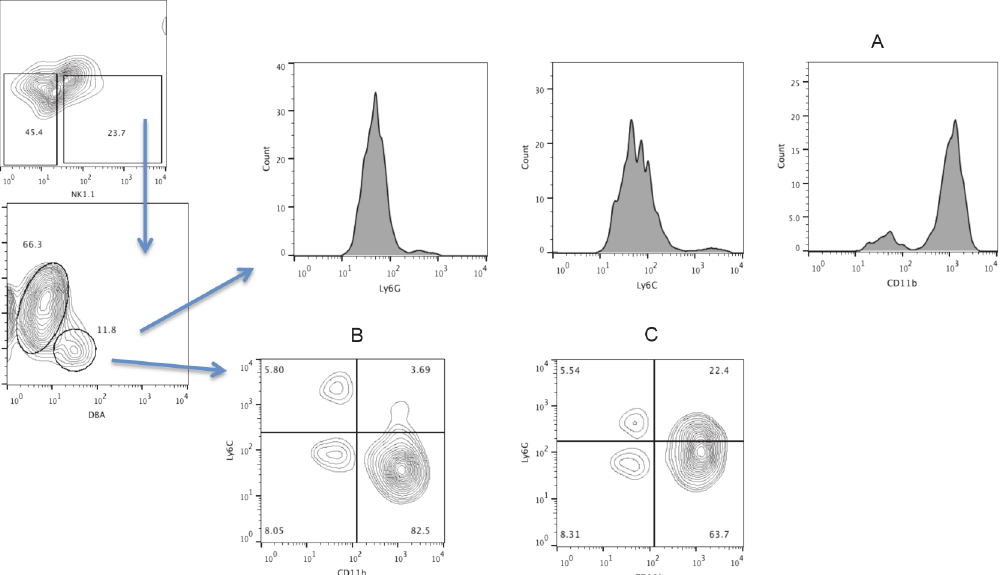
Fig 8. Expression of CD11b, Ly6C and Ly6G on uNK cells from CBA mice. Female CBA mice were allogeneically mated toC57BL/6 males and uterine lymphocytes were isolated between GD 10.5 to 12.5. Expression of CD11b, Ly6C and Ly6G was determined on the NK1.1 - DX5 - DBA + cell population. Data are representative of at least 4